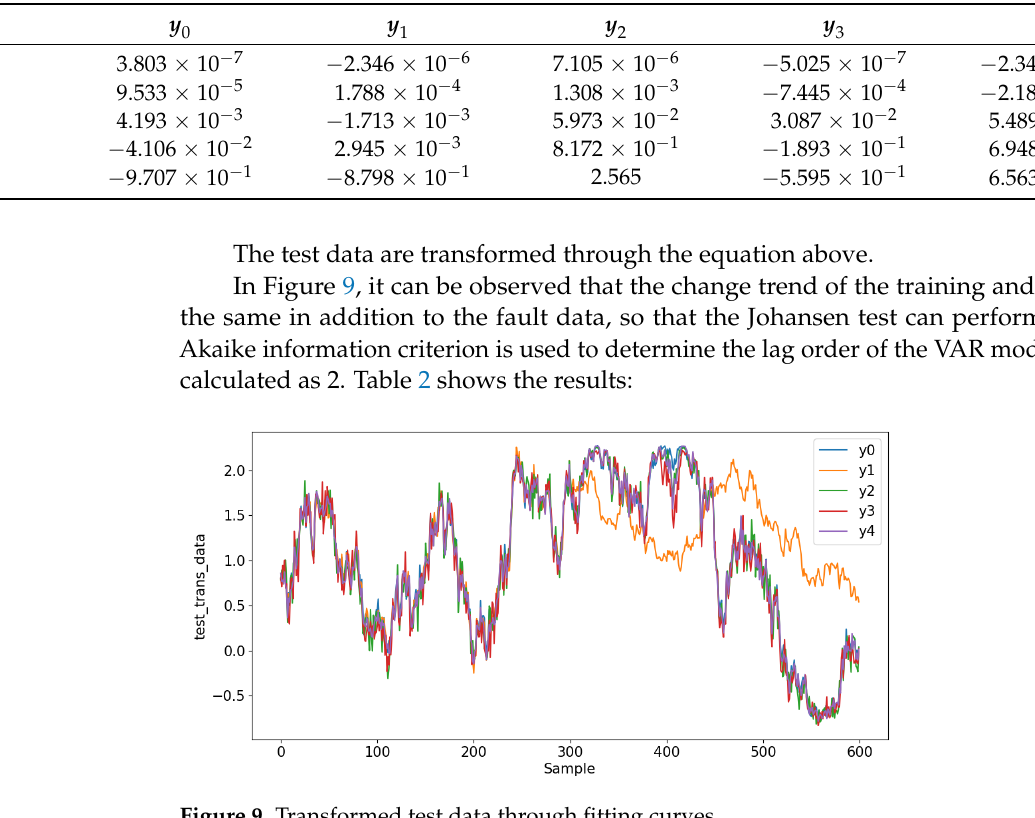
Figure 8. Transformed train data by ACE. Table 1. Polynomial fitting coefficient table.